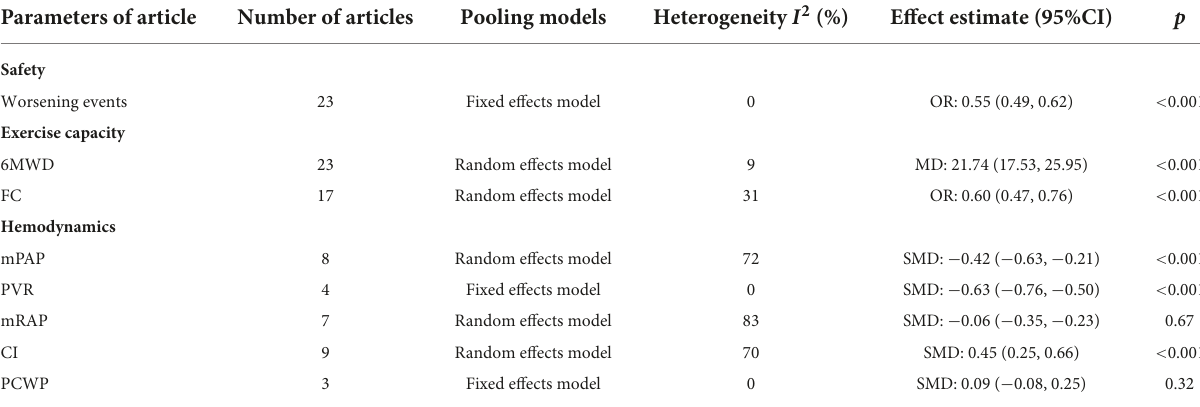
TABLE 4 Data on safety, exercise capacity, and hemodynamics from included studies.